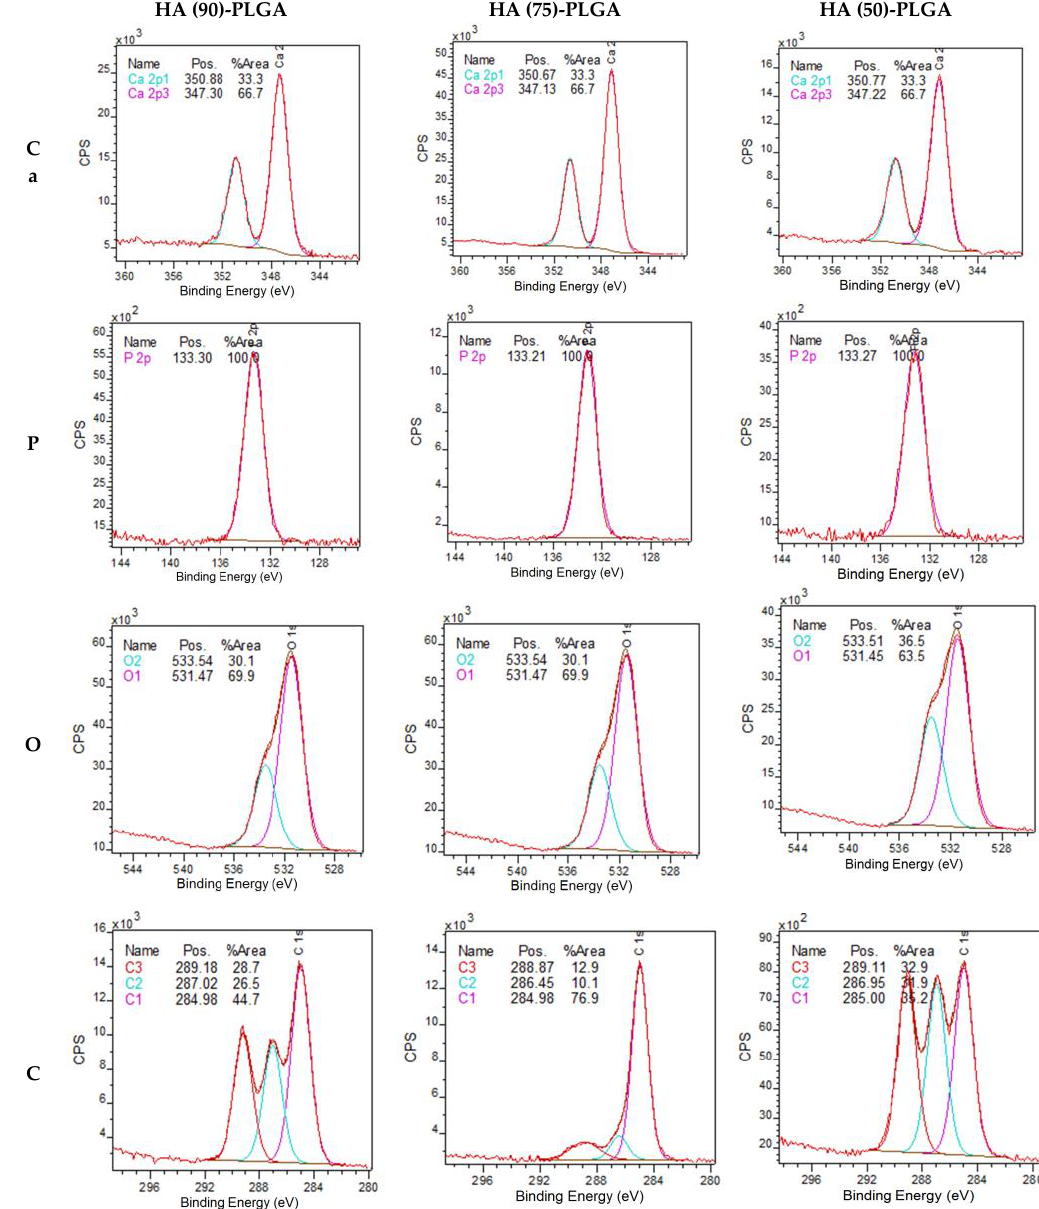
Figure 11. XPS spectra of Ca2p, P2p, O1s and C1s surfaces of composite materials. Binding Energy (eV) The XPS results (Table 5) showed that on the surface of HA (75)-PLGA, the carbon content is significantly less than on the surface of HA (90)-PLGA and HA (50)-PLGA. This is probably due to the fact that the HA (75)-PLGA sample has a different phase composition from the others, which led to a change in the nature of the coating. Table 5. Elemental composition of the surface of composites, thickness 5–10 nm. Element Content on the Surface, at. Sample